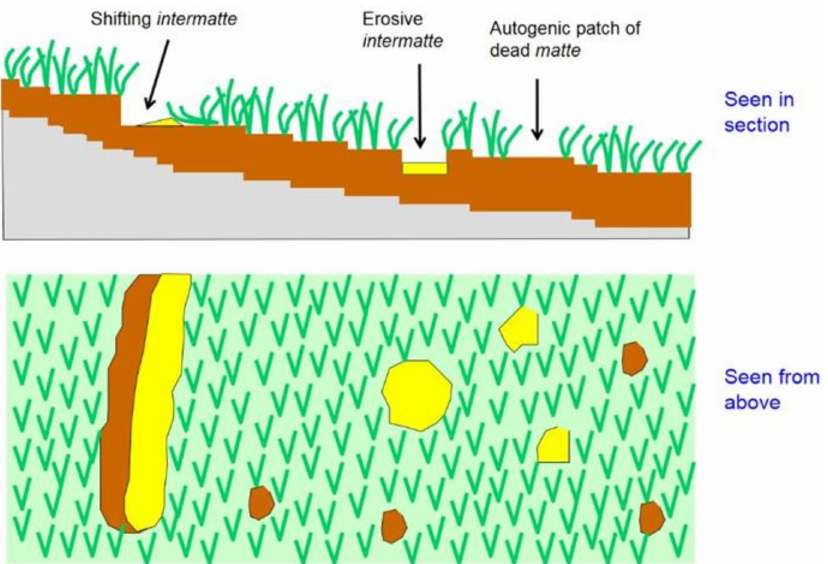
Figure 2. Areas of dead matte of natural origin in a plain type meadow of Posidonia oceanica . The shoreline is to the left. From Boudouresque et al. [55], adapted.